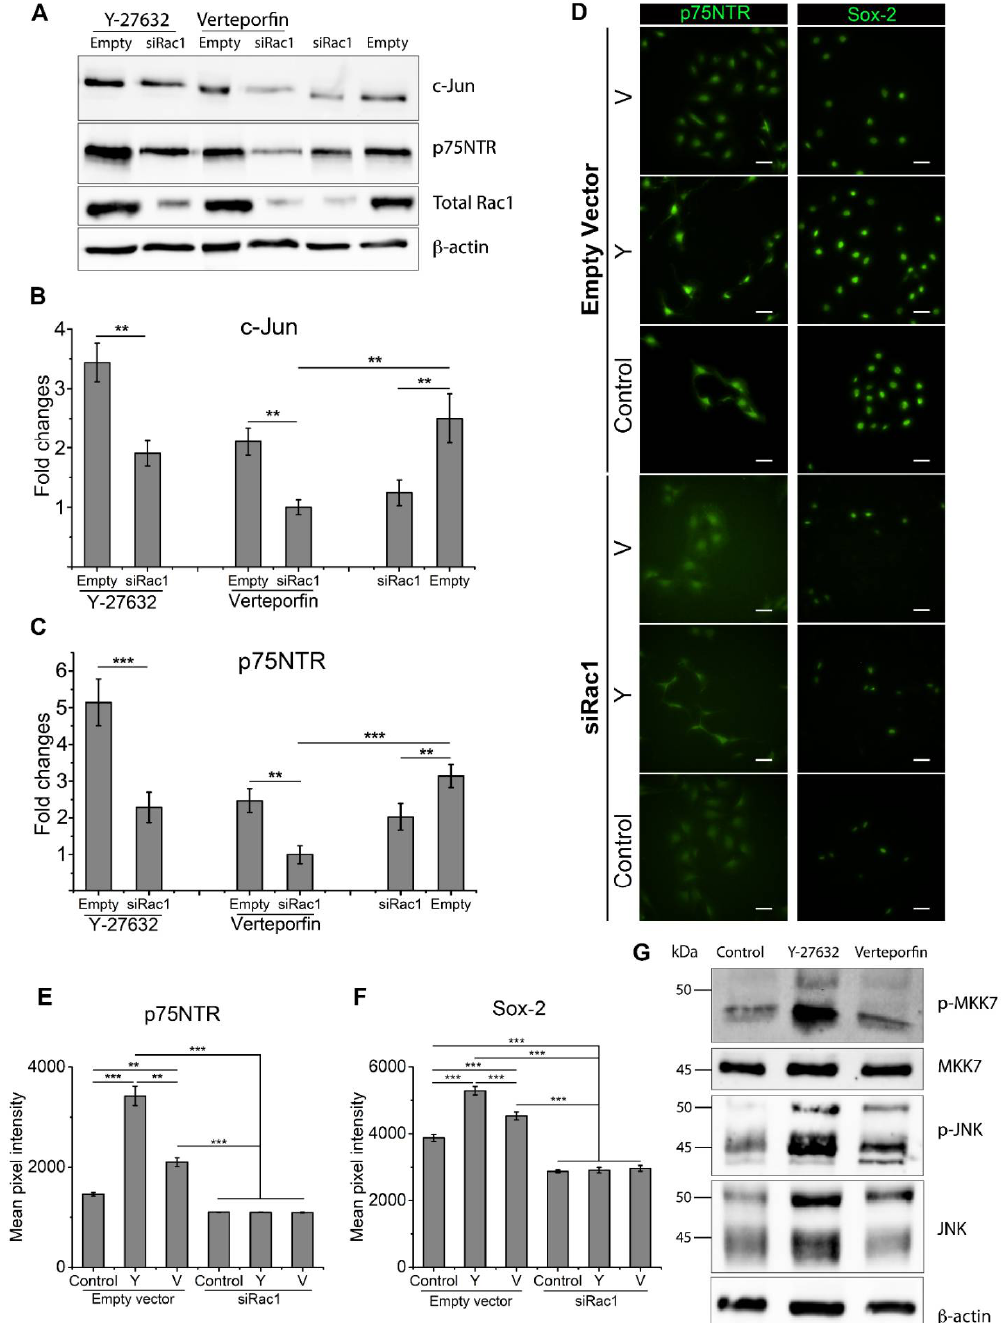
Figure 2. RhoA and YAP/TAZ inhibition led to increased expression of regenerative markers c-Jun, p75NTR, and Sox-2 through the activation of Rac1/MKK7/JNK signaling. ( A – C ) Active Rac1 inhibition via siRac1 significantly lowers c-Jun and p75NTR expression with RhoA and YAP/TAZ inhibition, showing no change in expression when Rac1 activity is blocked by siRac1 transfection. Four cell lysates were created for Western blot quantification. ( D – F ) Immunofluorescent stained Schwann cells treated with a combination of Y-27632, Verteporfin, or siRac1 showing expression of p75NTR and Sox-2. Three unique trials with a minimum of 42 cells per trial were quantified. Scale bar = 50 µ m. ( G ) Rac1/MKK7/JNK expression when treated with Y-27632 or Verteporfin. Data are presented as the mean ± SEM. ** p < 0.005, *** p < 0.0005, p -values found in Supplemental Table